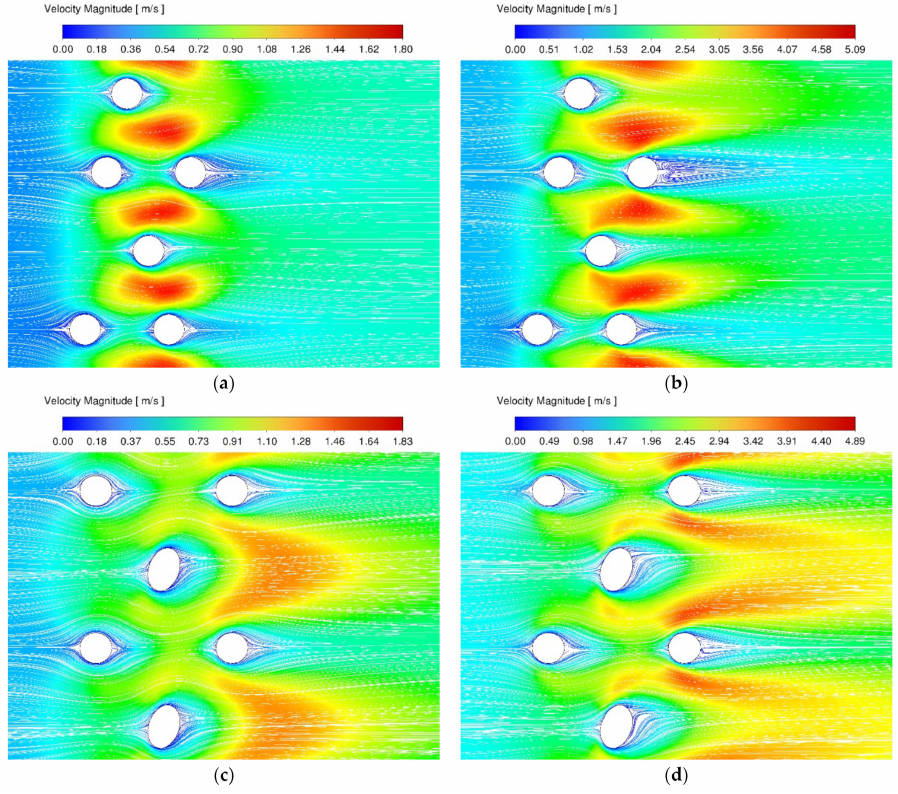
Figure 6. Velocity pathlines for: ( a ) Geometry A, contact time of 0.001 s; ( b ) Geometry A, contact time of 0.00025 s; ( c ) Geometry B, contact time of 0.001 s; ( d ) Geometry B, contact time of 0.00025